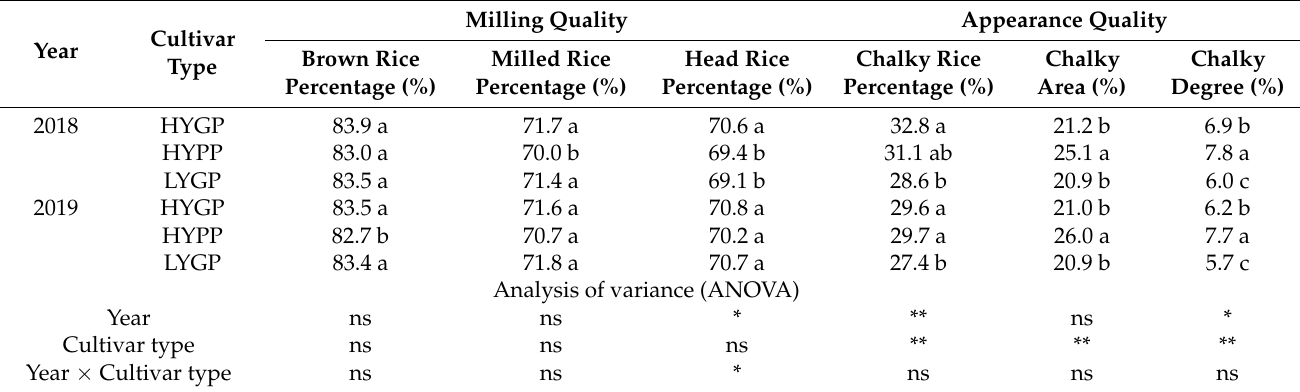
Table 5. Milling and appearance qualities of rice cultivar types.